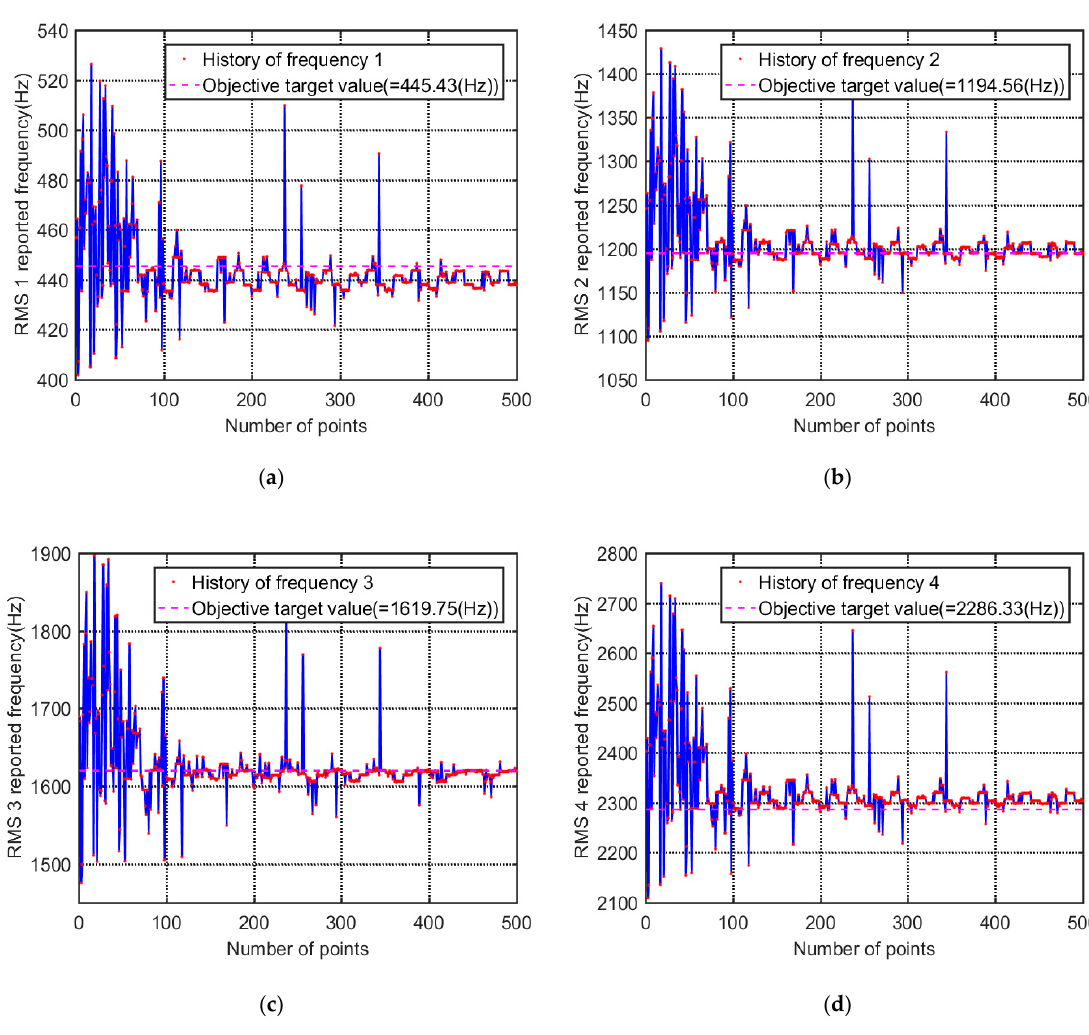
Figure 12. Convergence of inherent frequencies along the updating process. ( a ) First natural frequency; ( b ) second natural frequency; ( c ) third natural frequency; ( d ) forth natural frequency.